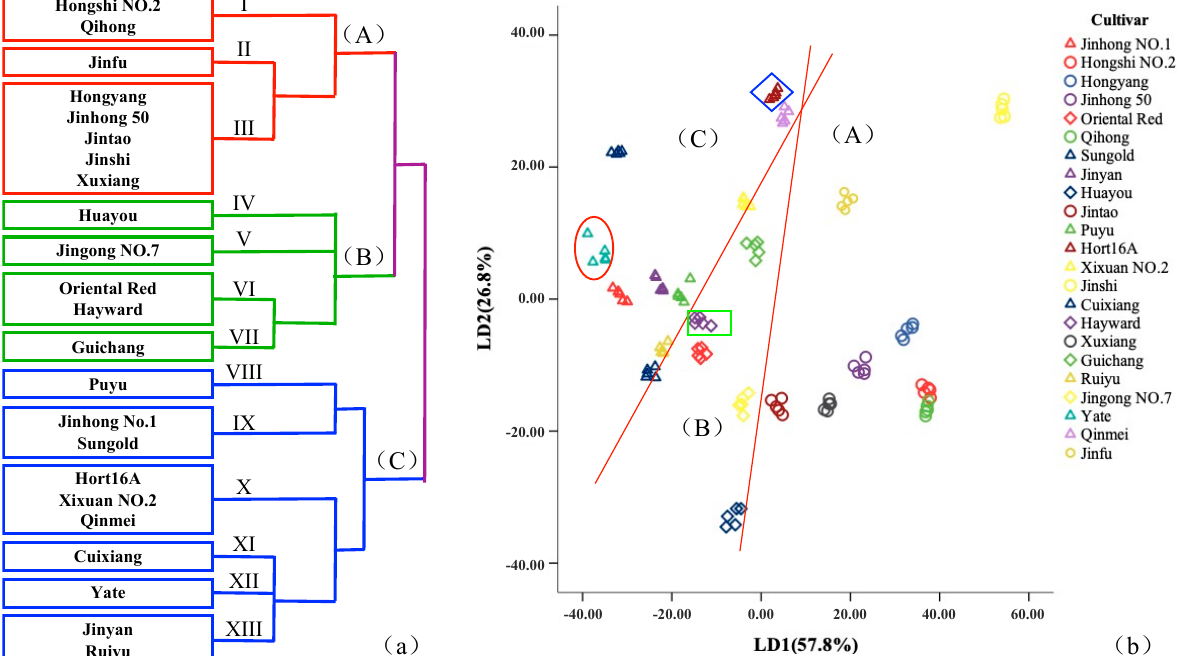
Figure 3. The results of cluster analysis ( a ) and LDA ( b ) (Sungold: red circle; Hayward: green box; Hort16A: blue rhombus) of different varieties of kiwifruit based on E-nose response data. (A–C: three major categories based on the E-nose re- sponse).